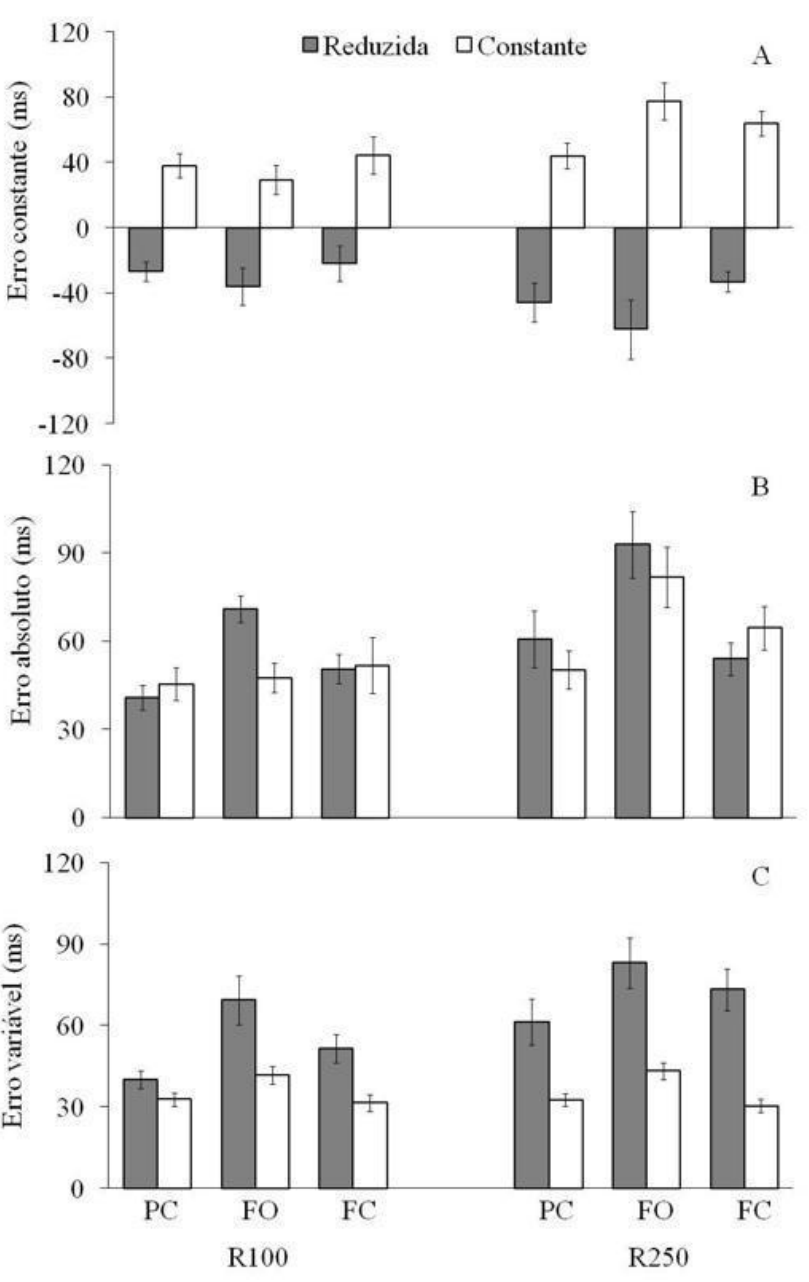
Figura 2 . Valores Médios dos Erros Temporais (ms) Constante (A), Absoluto (B) e Variável (C), em Função da Condição Visual (Perseguição Contínua, PC; Foco na Origem, FO; e Foco no Contato, FC), Velocidade (Constante x Reduzida) e Tempo de Redução de Velocidade (R100 x R250); Traços Verticais Representam o Erro